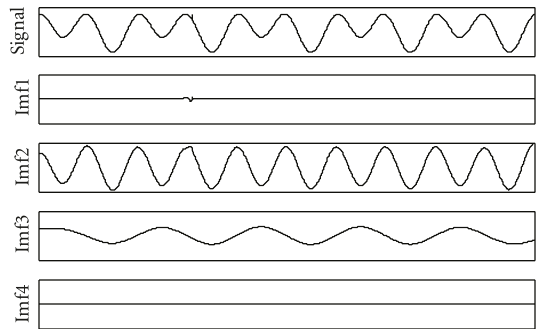
Figure 5: The EMD result of the proposed